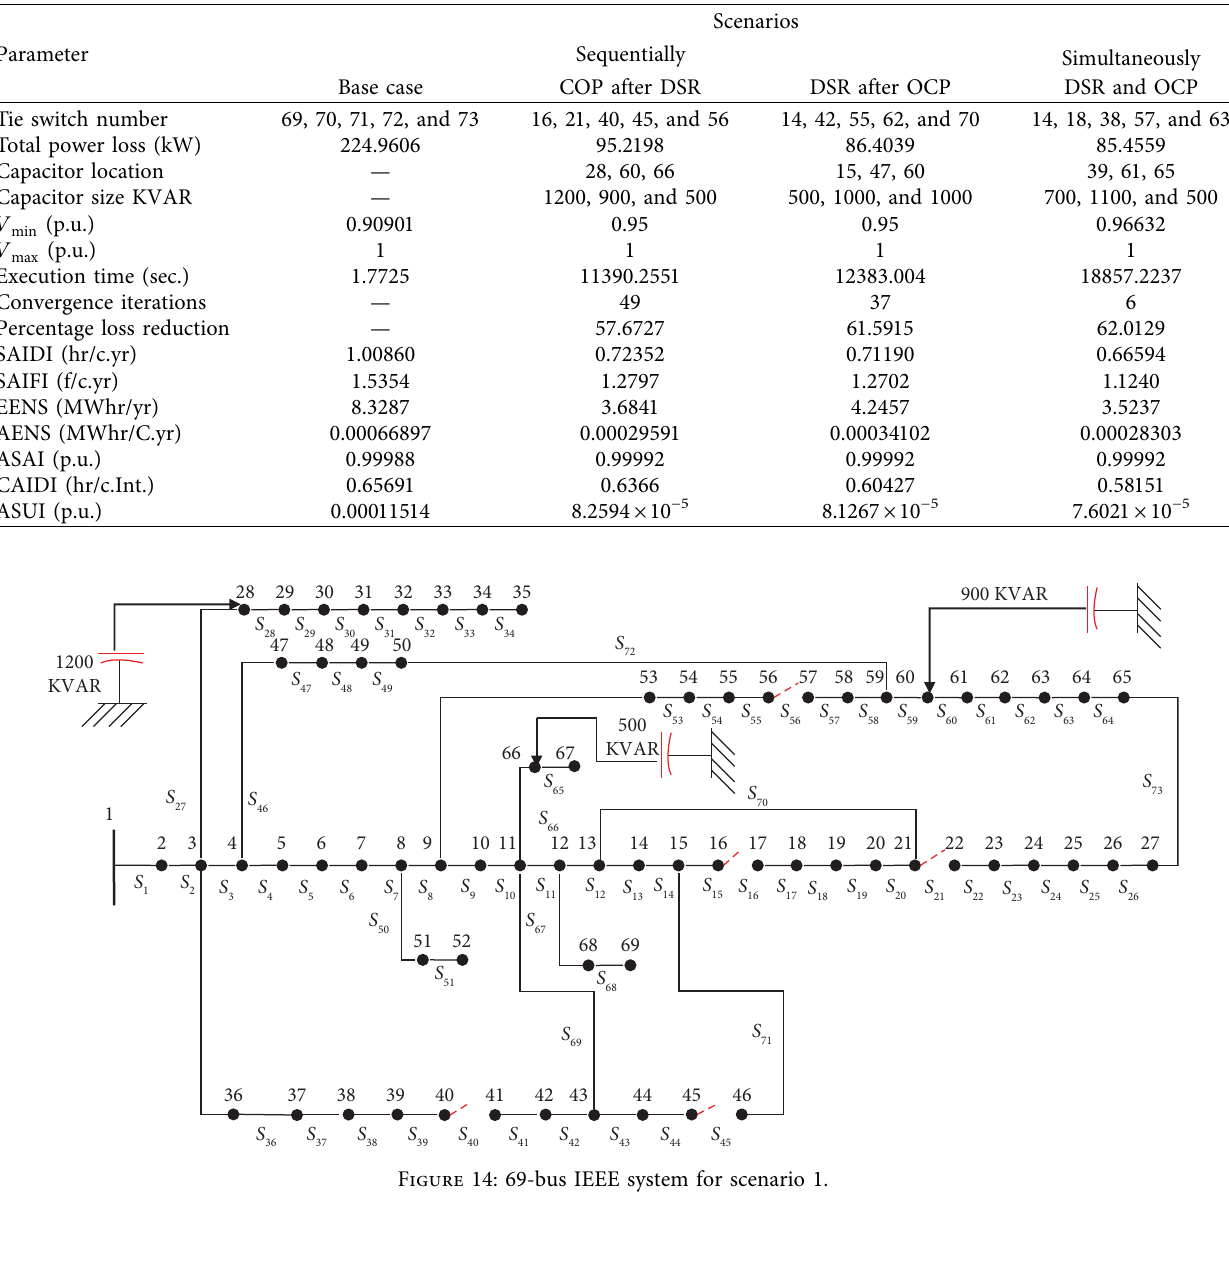
Table 2: Te results and comparison among the scenarios for the IEEE 69-bus RSD.